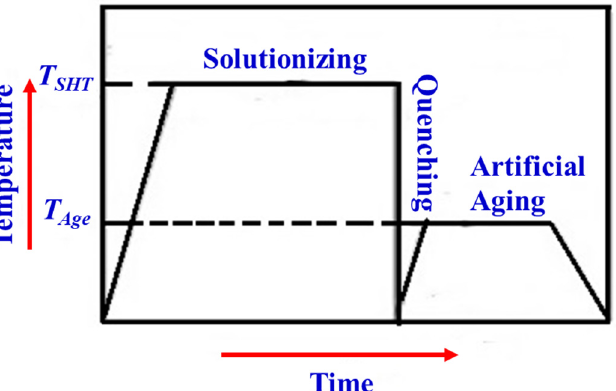
Figure 5. Schematic diagram of precipitation hardening (temperature vs. time diagram).